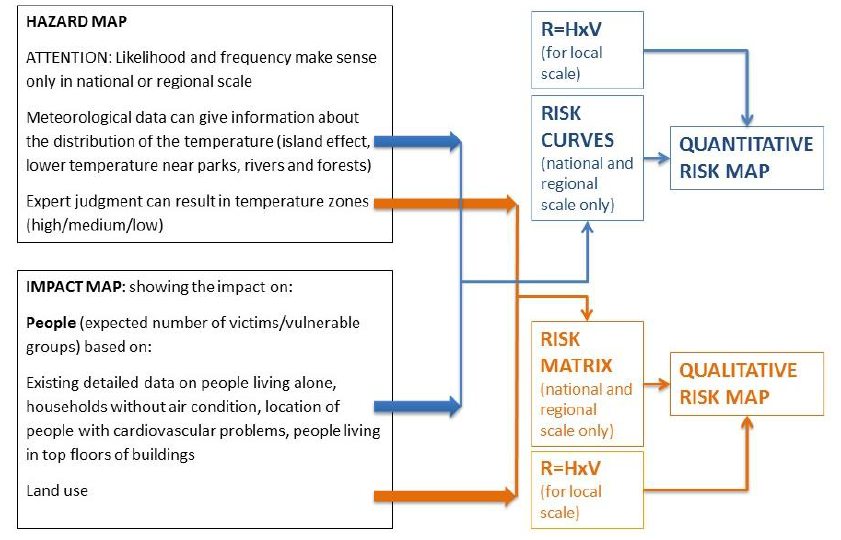
Figure 10. The CRAM adapted for heat waves [46].